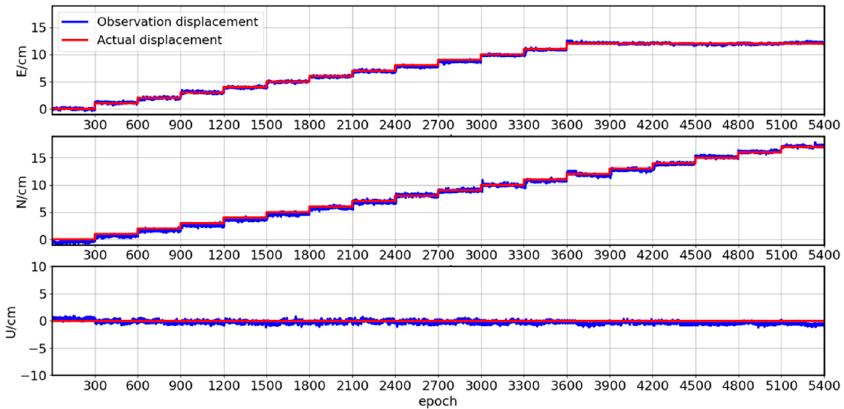
Figure 4. Displacements of mobile quantitative observations in the E, N, and U directions for the proposed constrained algorithm.